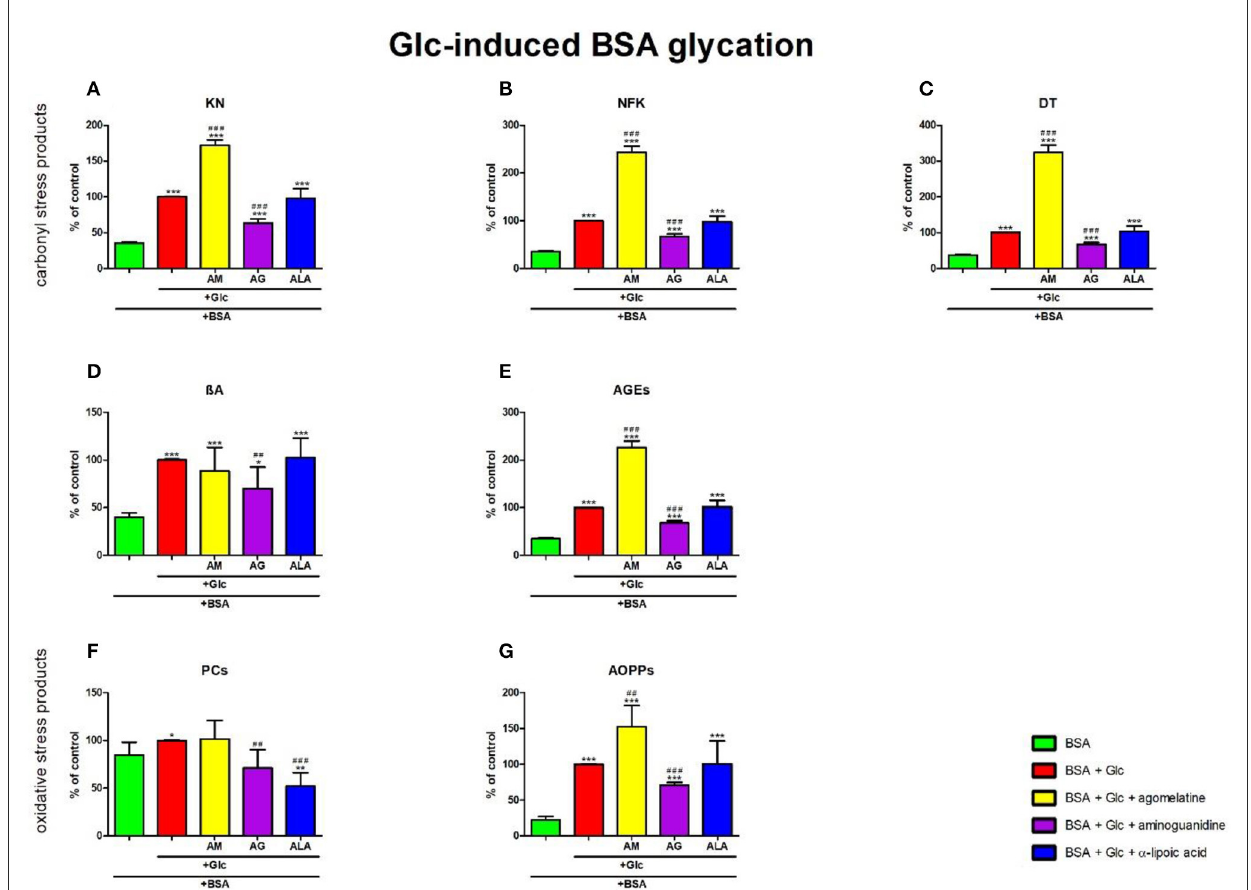
FIGURE5 Effects of agomelatine addition to glucose (Glc)-glycated bovine serum albumin (BSA) on carbonyl stress products (A–E) and oxidative stress products (F, G) . AG, aminoguanidine; AGEs, advanced glycation end products; ALA, α -lipoic acid; AM, agomelatine; AOPPs, advanced oxidation protein products; β A, β -amyloid; BSA, bovine serum albumin; DT, dityrosine; Glc, glucose; KN, kynurenine; NFK, N-formylkynurenine; PCs, protein carbonyls. * p < 0.05 vs. negative control (BSA); ** p < 0.01 vs. negative control (BSA); *** p < 0.001 vs. negative control (BSA); ## p < 0.01 vs. positive control (BSA + Glc); ### p < 0.001 vs. positive control (BSA +